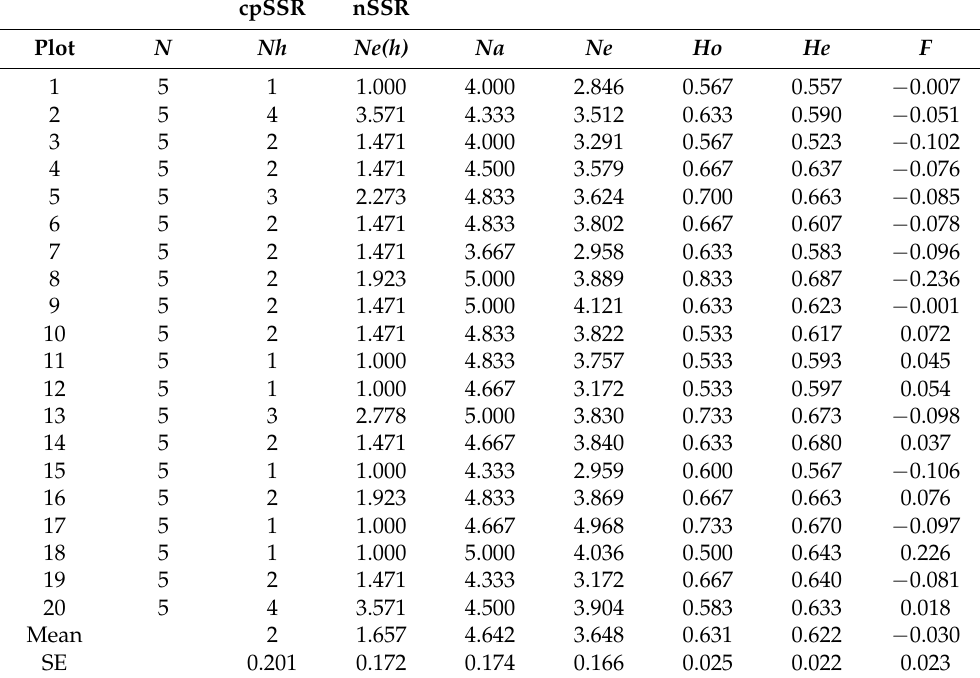
Table 3. Measures of genetic diversity at cpSSR and nSSR markers for the 20 plots of the study. cpSSR nSSR Plot